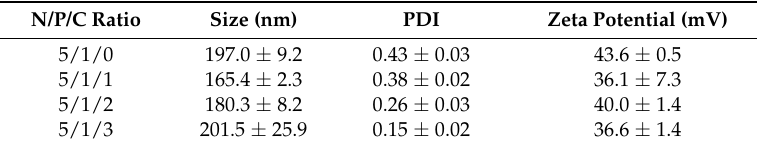
Table 2. Physicochemical properties of γ -DDNPs prepared by different N/P ratios ( n = 3).